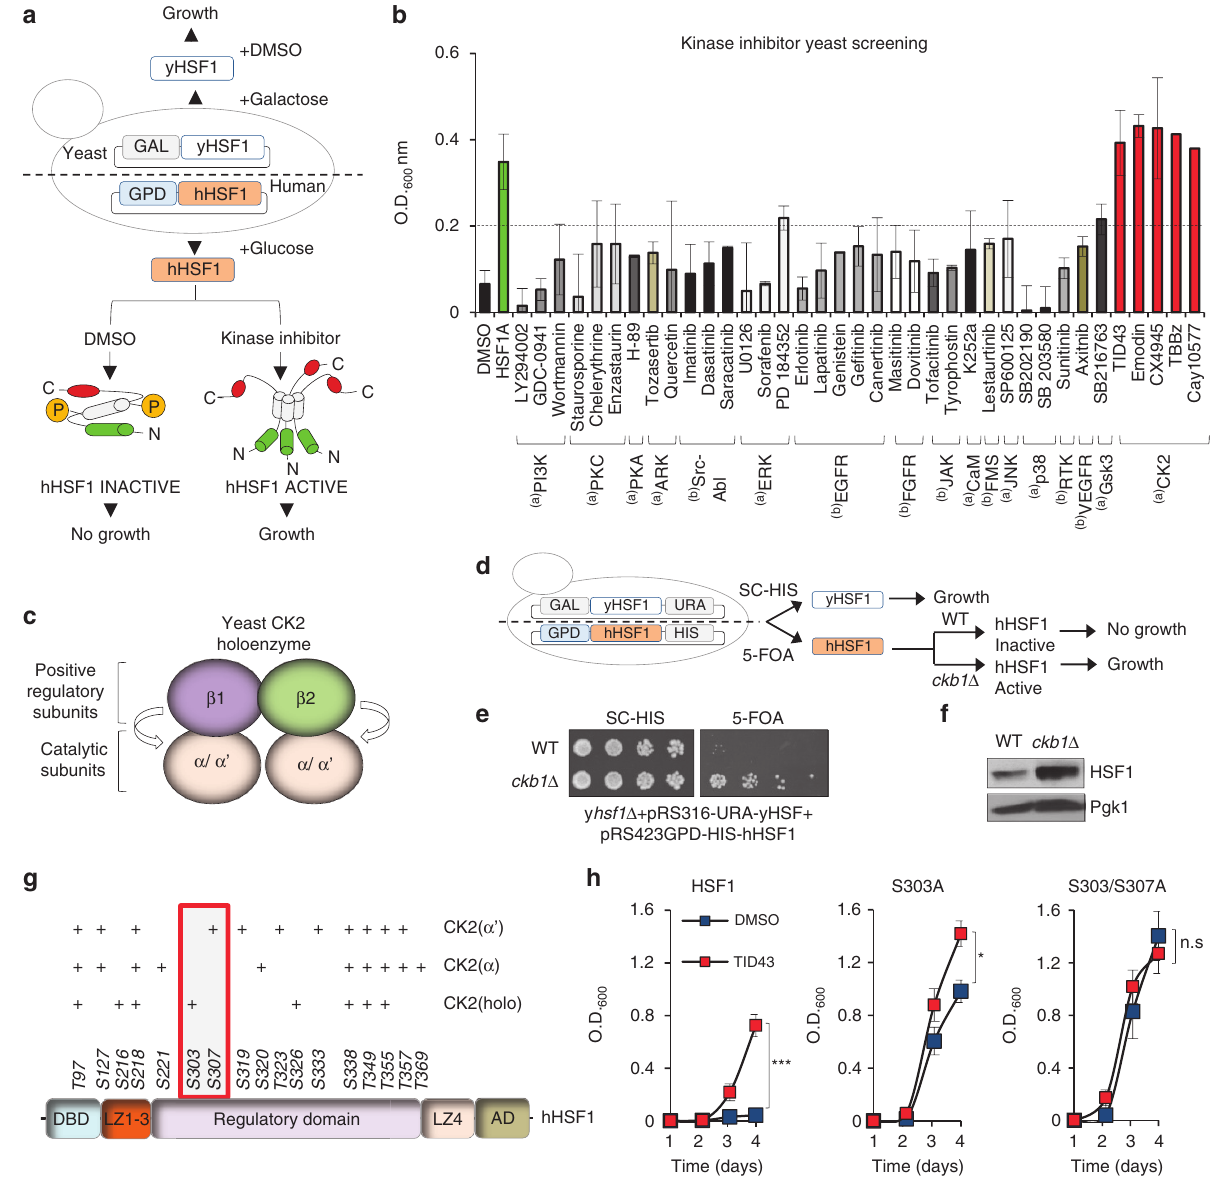
Figure 3 | CK2 kinase modulates human HSF1 activity and stability in yeast. ( a ) Experimental design of humanized HSF1 yeast screen for kinase inhibitors that promote yeast HSF1-dependent growth. ( b ) Yeast cells expressing human HSF1 cultivated with ser-thr kinase inhibitors and growth (OD 600 nm) monitored over 4 days. Data presented correspond to results at 20nM concentration. Similar results were obtained at other tested drug concentrations from 2nM to 20 m M. DMSO was negative control and HSF1A used as positive control. (a ¼ Ser/Thr kinases, b ¼ Try kinases). Error bars represent ± s.e.m., ( n ¼ 4). ( c ) Yeast CK2 holoenzyme subunit composition and function. ( d ) Experimental design of humanized HSF1 yeast screen for CKB1 deletion that promote yeast HSF1-dependent growth. ( e ) WT and CKB1 mutant strain ( ckb1 D ) grown in SC-His or 5-FOA medium for 3 days at 30 (cid:2) C. ( f ) Protein extracts from WT ( CKB1 ) and mutant strain ( ckb1 D ) immunoblotted for human HSF1 using Pgk as loading control. ( g ) Summary of human HSF1 phosphorylation sites mediated by recombinant CK2 a , CK2 a 0 or CK2 holoenzyme in vitro and analysed by phosphoproteomics, where ( þ ) indicates detection of phosphorylation, DBD; DNA binding domain; LZ1-3 and LZ4; leucine zipper domains. ( h ) Yeast expressing WT human HSF1, S303A or S303/S307A mutants grown in glucose with DMSO or 10 m M TID43 and OD 600 nm monitored over 4 days. Statistical significance was measured 4 days of growth. Error bars represent ± s.e.m., ( n ¼ 3). Unpaired t -test; NS, no significant; * P o 0.05, *** P o 0.001.